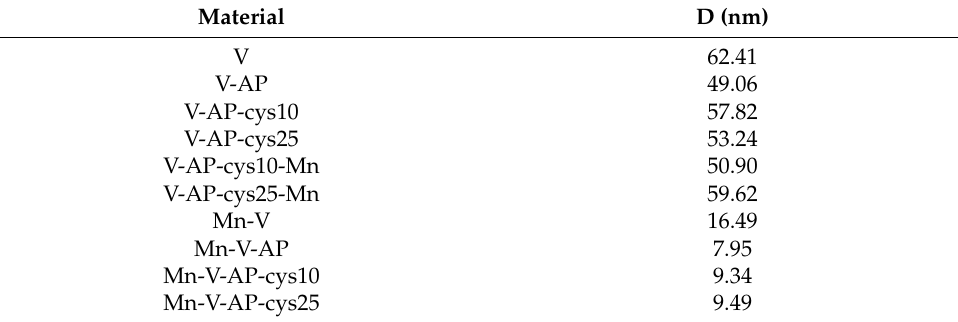
Table 1. Crystallite size of all vaterite materials.